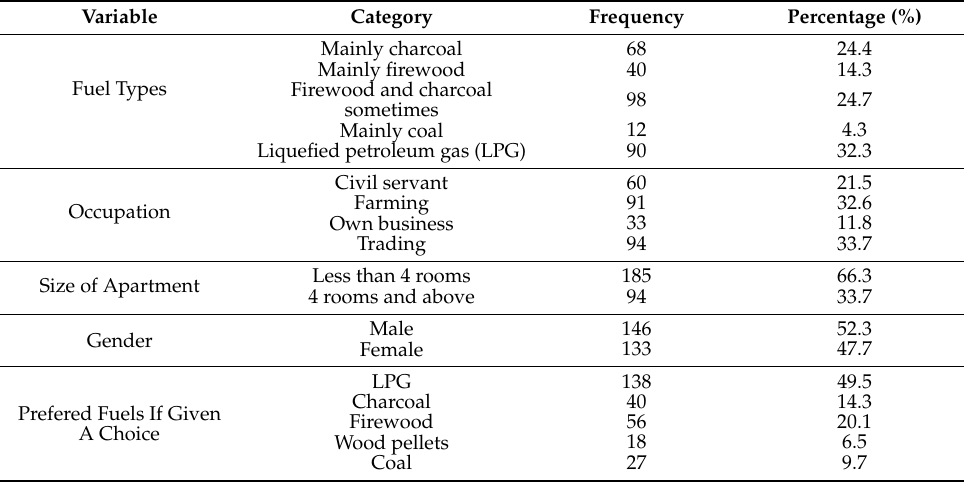
Table 2. Statistical summary of social characteristics of the